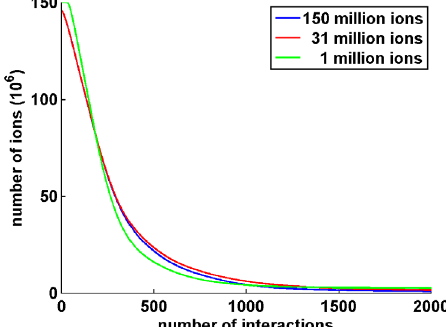
FIG. 8. Clearing times of ion clouds with different width: 1 cm and 2 cm of mixture 5, beam pipe with elliptical cross-section.